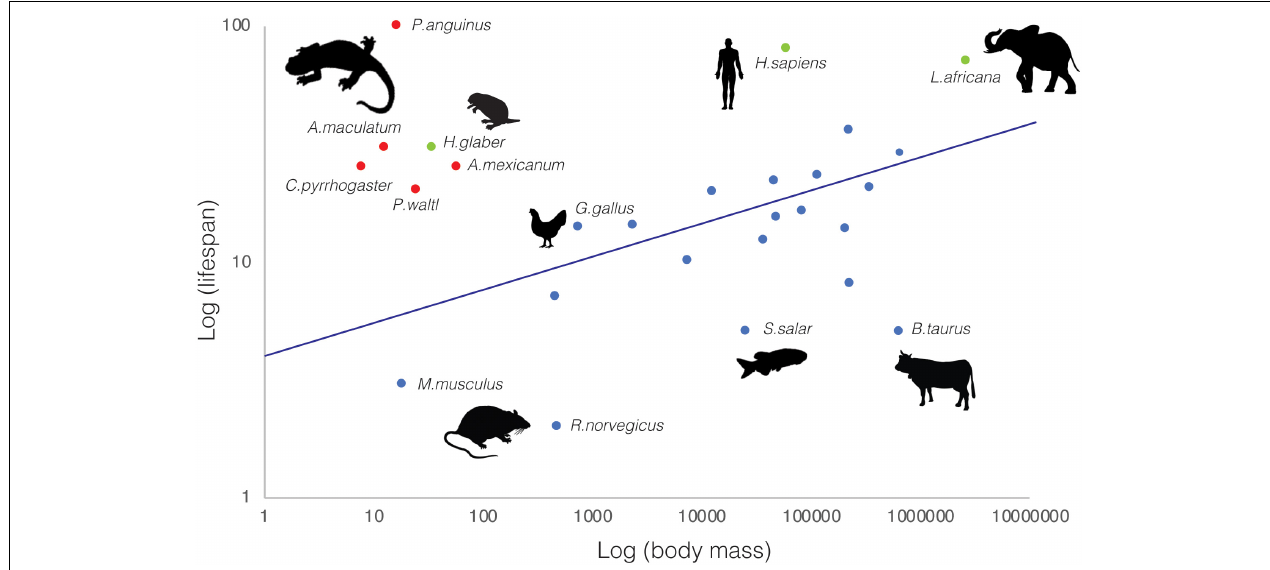
FIGURE 1 | Salamanders are lifespan outliers. Relationship between average body mass (g) and lifespan (years) for selected salamander (red) and representative vertebrate species (blue). Additional upper-end lifespan outliers (naked mole rat— Heterocephalus glaber -, African bush elephant— Loxodonta africana— and human— Homo sapiens —) are indicated in green. Animal silhouettes (not drawn to scale) represent the vertebrate clades to which the selected representative species belong to. Data was obtained from various sources, including ADW Animal diversity web, AnAge (Tacutu et al., 2018) and Amniote Life History Database (Myhrvold et al.,